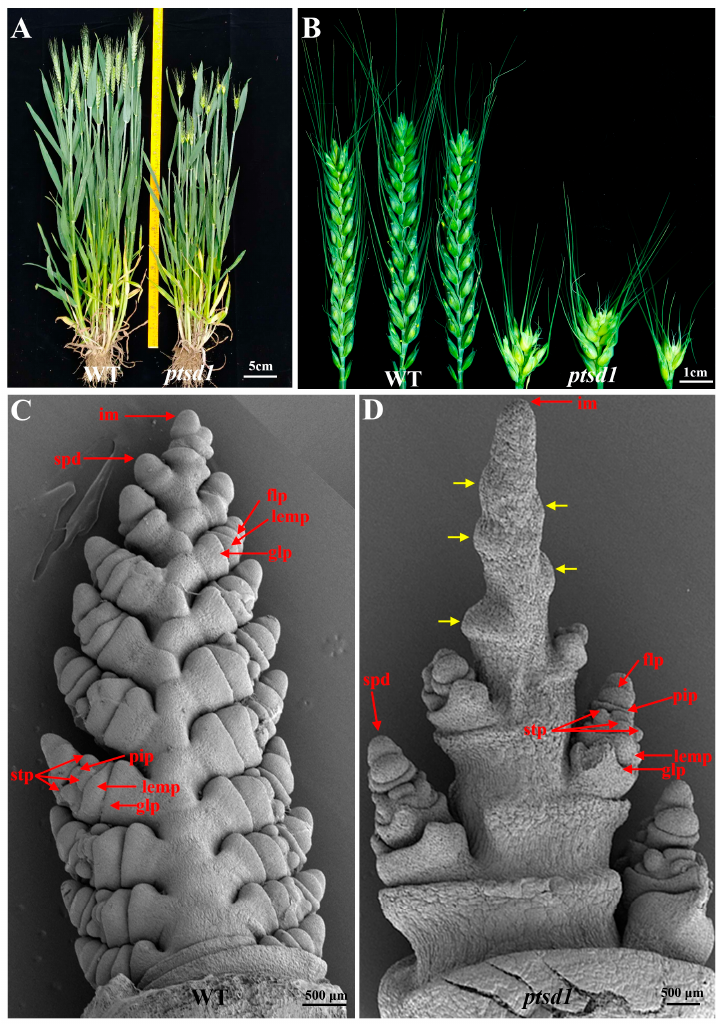
Figure 1. The individual plants and spikes of wild type (WT) and mutant ptsd1 . ( A ) The plant phenotype of WT (left) and mutant ptsd1 (right); ( B ) The spikes of WT (left) and mutant ptsd1 (right); ( C ) The ultrastructure of the young spikes on WT at terminal spikelet stage; ( D ) The ultrastructure of the young spikes on mutant ptsd1 at late terminal spikelet stage. Yellow arrowheads indicate the undifferentiated upper spikelet primordia. im, inflorescence meristem; spd, spikelet meristematic dome; glp, glume primordium; lemp, lemma primordium; flp, floret primordium; stp, stamen primordium; pip, pistil primordium.